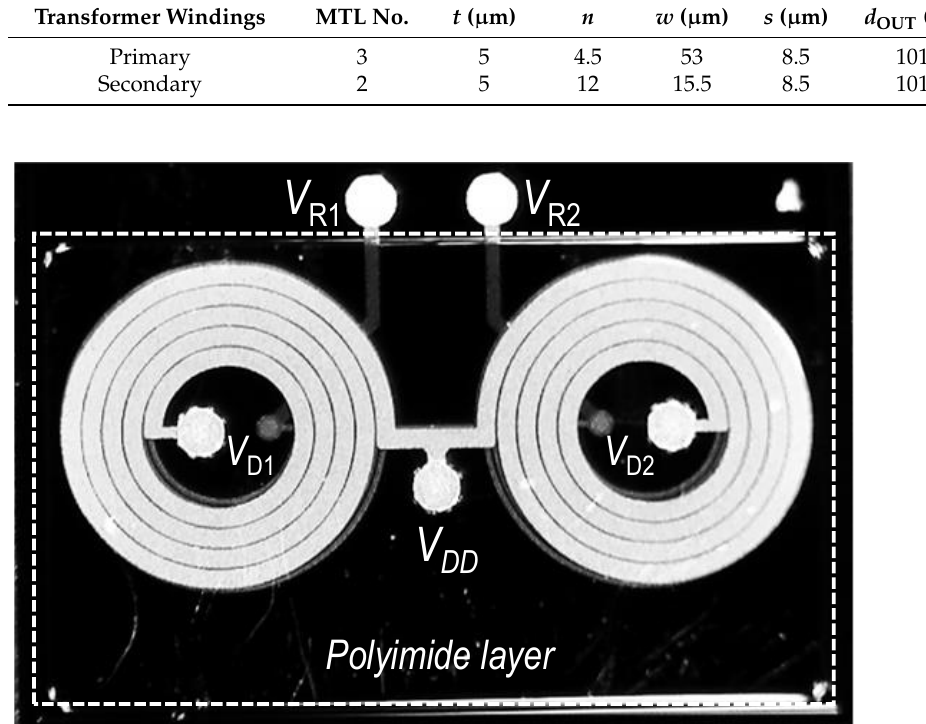
Figure 9. Micrograph of the stand-alone polyimide isolation transformer (Chip T). Table 2. Geometrical parameters of the polyimide isolation transformer.